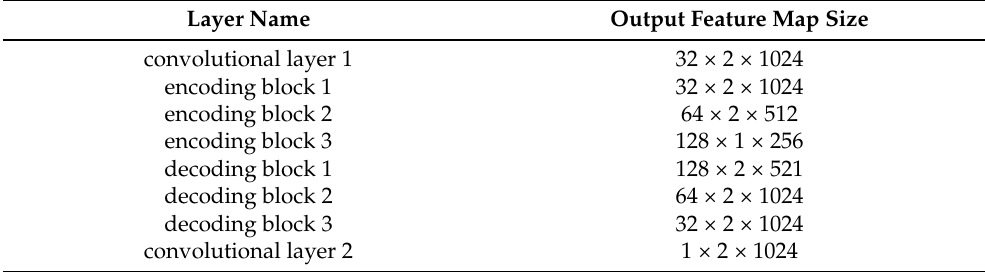
Table 1. Denoising Autoencoder’s